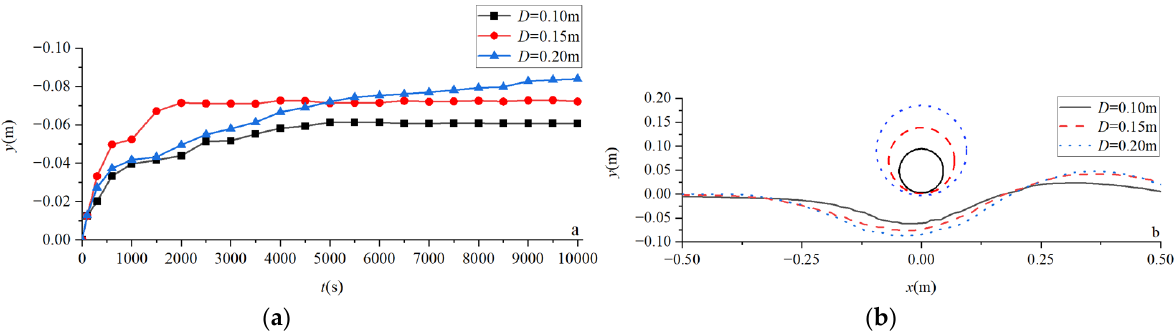
Figure 10. Comparisons of scour depth and terrain under the pipeline for different pipeline diameters. ( a ) The scour depth and ( b ) The scour terrain.